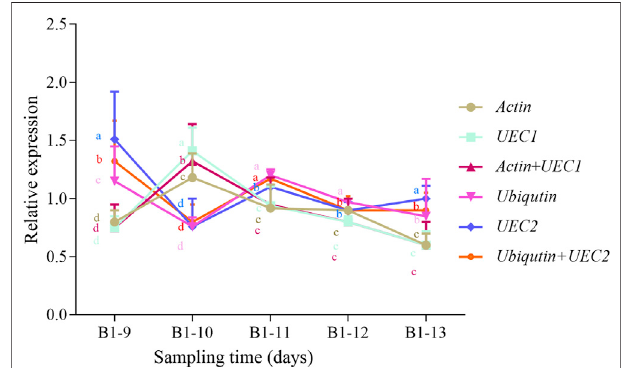
FIGURE 5 | Relative expression of selected genes: most stable ( Actin + UEC1 ) and most unstable ( UEC2 + TIP41 ) relative to the reference gene ( NCED1 ) under drought stress condition of matured leaves of young R. delavayi plant.Samplingtimesconsistedof9,10,11,12,and13 daysof drought stress (no watering) condition denoted B1-9, B1-10, B1-11, B1-12, and B1-13, respectively. The error bars represent standard deviations computedonthree replications.Differentletters ofthesame colorsofthelines represent signi fi cant difference ( p < 0.05 ) at each time point based on Duncan ’ s Multiple Range